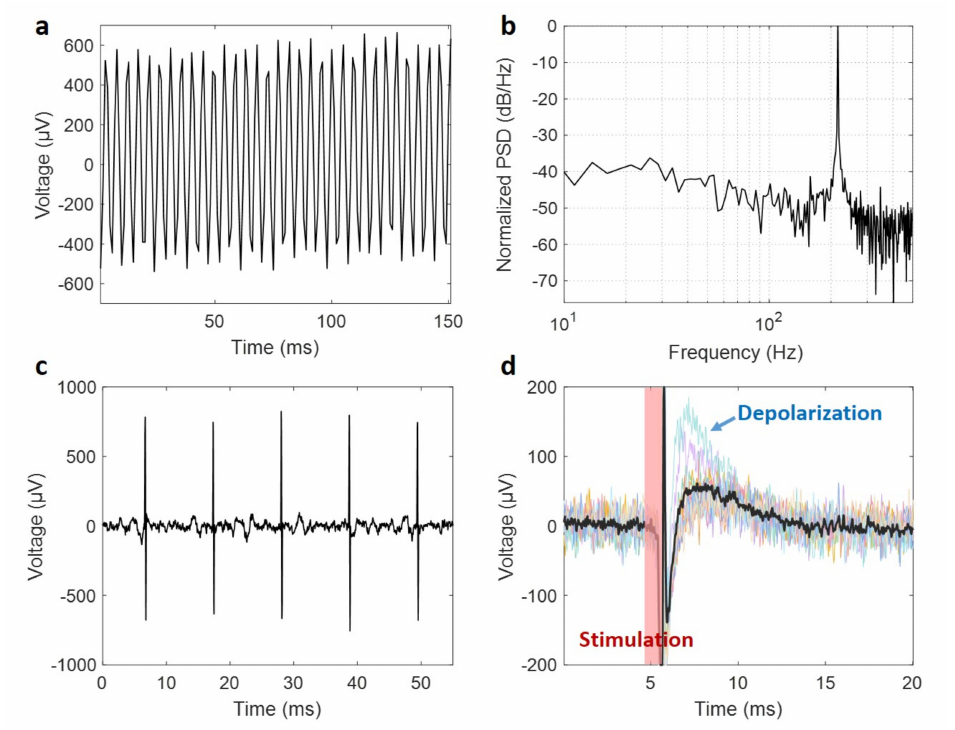
Figure 8. A benchtop saline and ex vivo brain slice experiment validate recording and stimulation microchips functionalized by post-processing: ( a ) a neurograin chip with planar Au electrodes in the recording mode, responding to a 200 Hz sinusoidal current injected into the conductive medium; ( b ) its corresponding power spectral density; ( c ) 100 Hz biphasic stimulation pulses generated in saline by the neurograin chip with PEDOT:PSS electrode; ( d ) The superimposed waveforms of depolarization induced by stimulation current from the chip in a mouse cortical